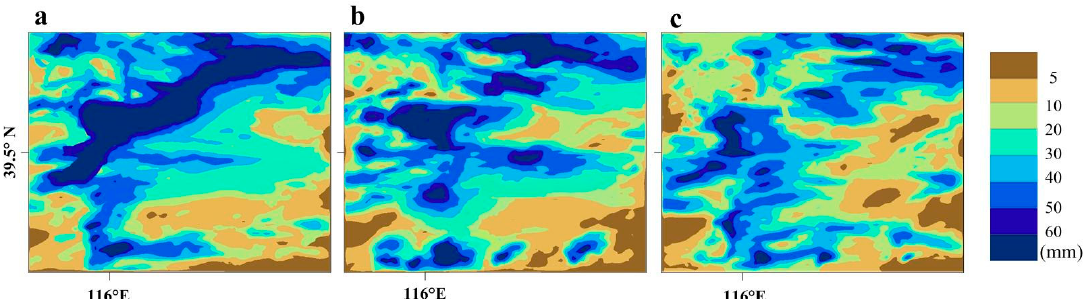
Figure 6. ( a – c ) Comparison of total precipitation distribution during two Figure 6. Comparison of total precipitation distribution during two weeks.